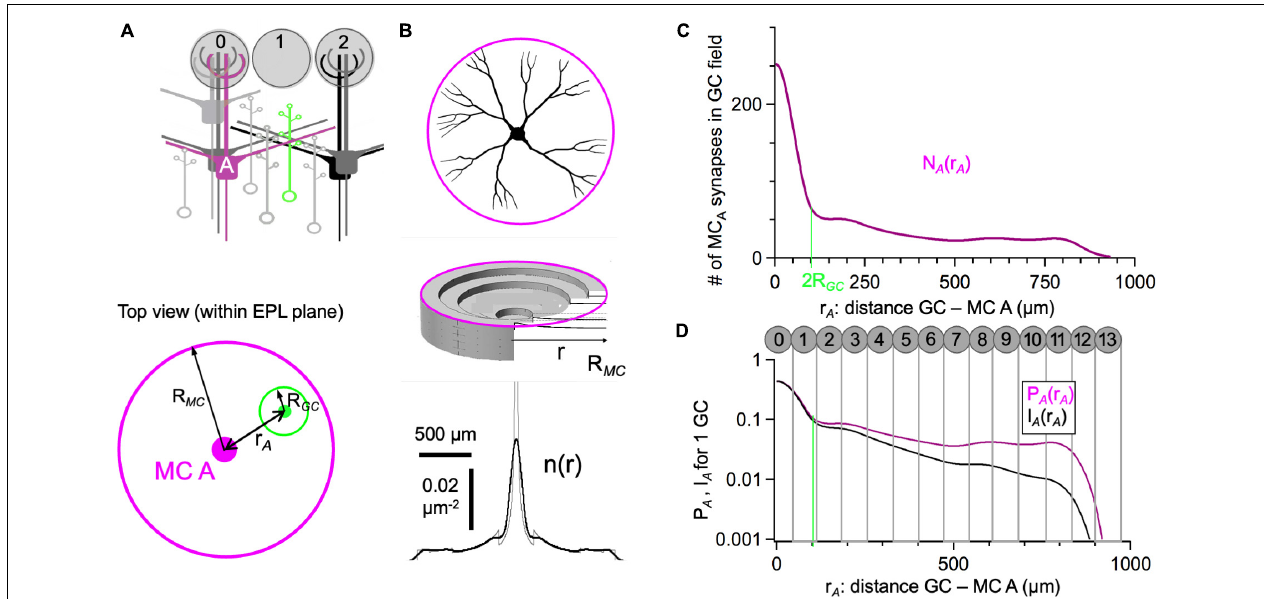
FIGURE 3 | Anatomical connectivity between individual mitral cells and granule cells. (A) Scheme of the MC-GC network, below the top view of the dendritic fields of MC A (magenta, field radius R MC ) and a GC (green, field radius R GC ). r A : distance MC-GC. (B) Synaptic density for single mitral cell with branching secondary dendrites as described in Eq. 1. The top graph shows a schematic view of a branching neuron, and the middle graph illustrates how the synaptic density was calculated with the position of the steps corresponding to the average branchpoint position. The bottom graph shows the average radial synaptic density n(r) for a branching cell including smoothing of the branchpoint positions. The gray line corresponds to the unsmoothed density as given in Eq. 1. (C) Number of synapses of MC A that a given GC at position r A can access (Eq. 3). 2R GC indicates the distance at which there is no more overlap with the GC dendritic field with the peak of n(r). (D) Probability P A that a GC at position r A will indeed connect to MC A (Eq. 6) and effective inhibitory impact I A (Eq. 7, from Figure 2C ). The spacing of glomeruli is indicated (diameter of glomeruli scaled to fit all 4,000 glomeruli into A EPL , see Section